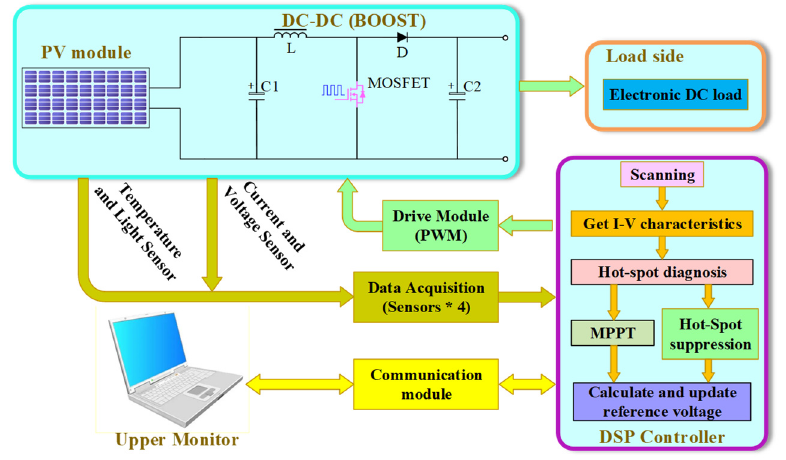
Figure 13. Overall block diagram of photovoltaic experimental platform.